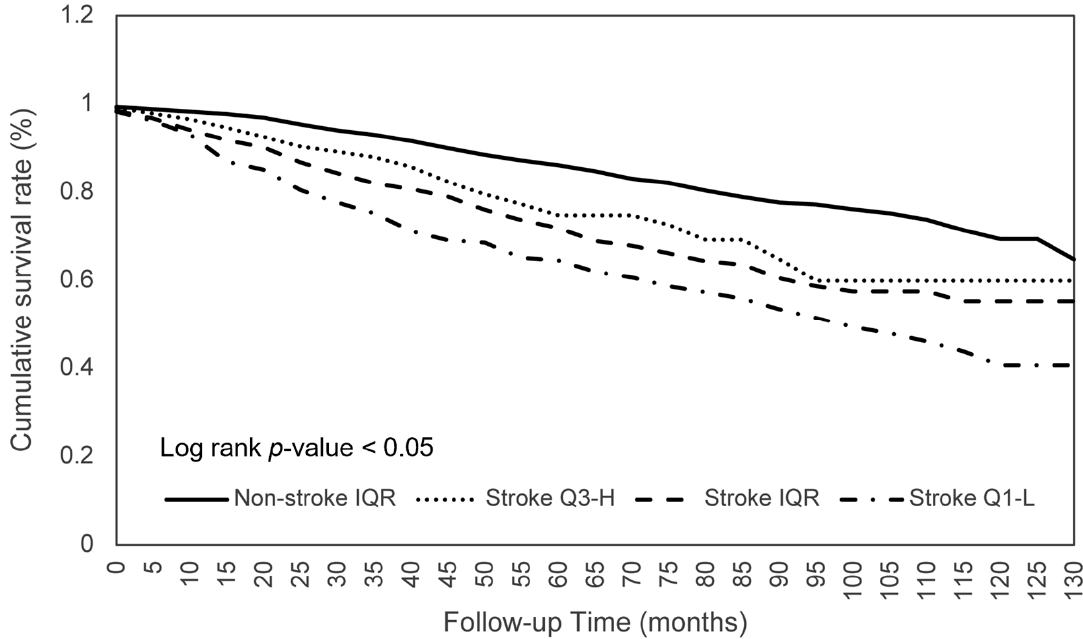
Figure 4. Moisture consumption in relation to the cumulative mortality rates. Abbreviations: Q1-L, Q1-lowest; IQR, interquartile range; Q3-H, Q3-highest. Table 4. Impact of dietary consumption on survival of stroke patients.